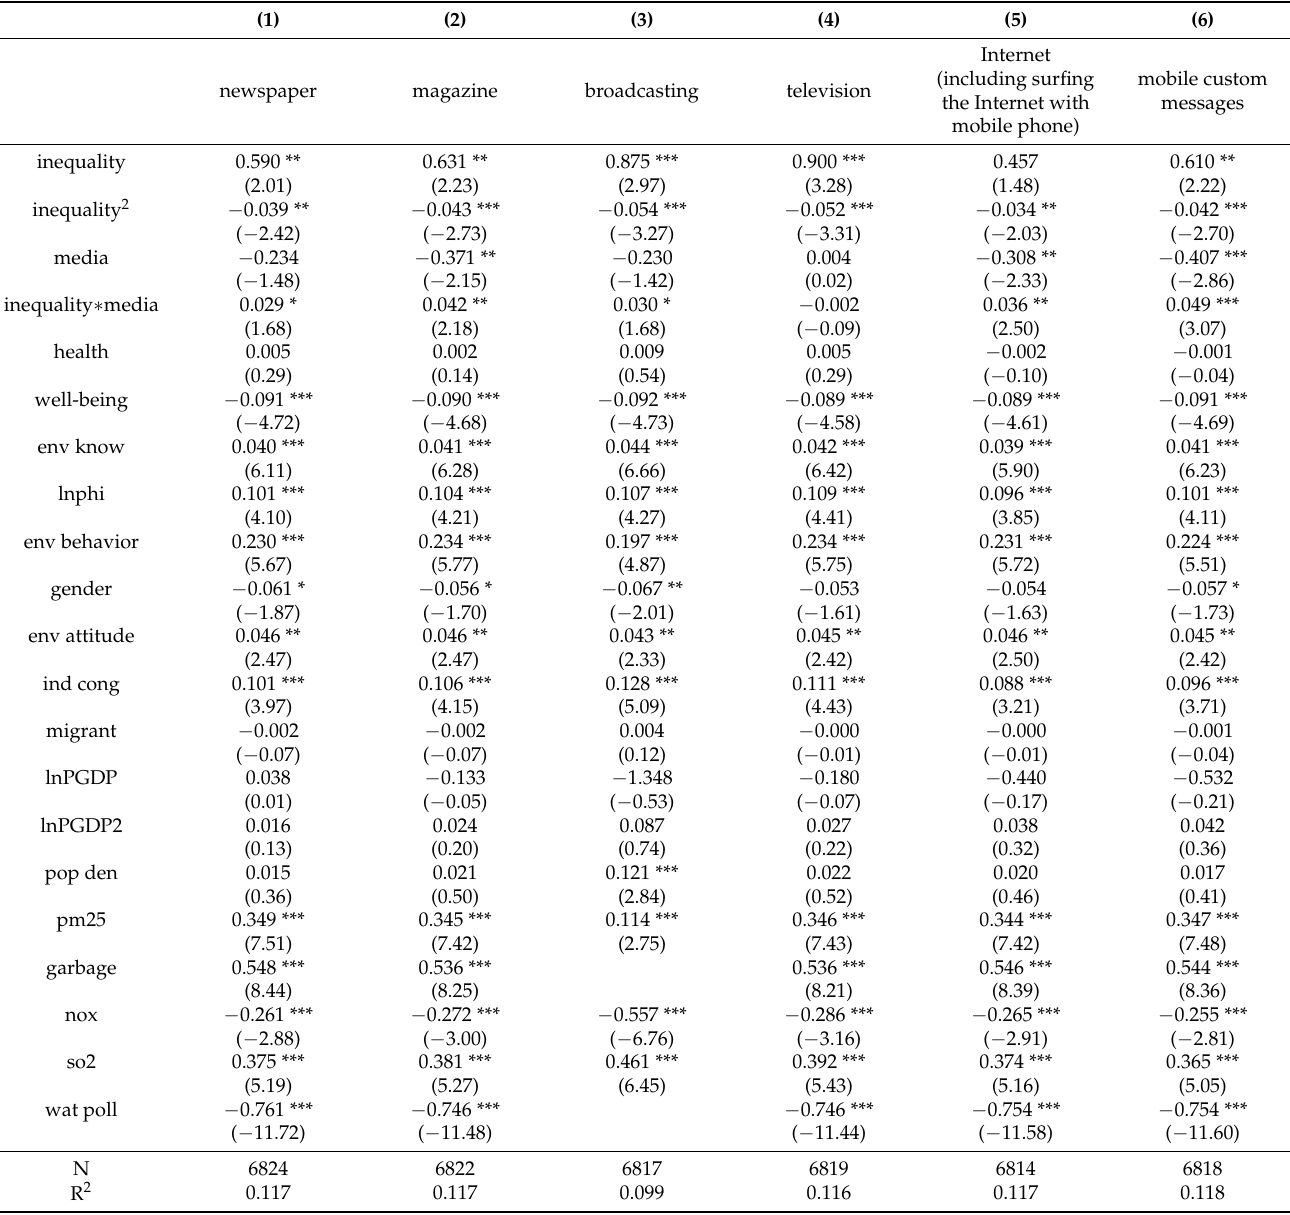
Table A13. The mechanism of the effect of individual-level income inequality on subjective environmental